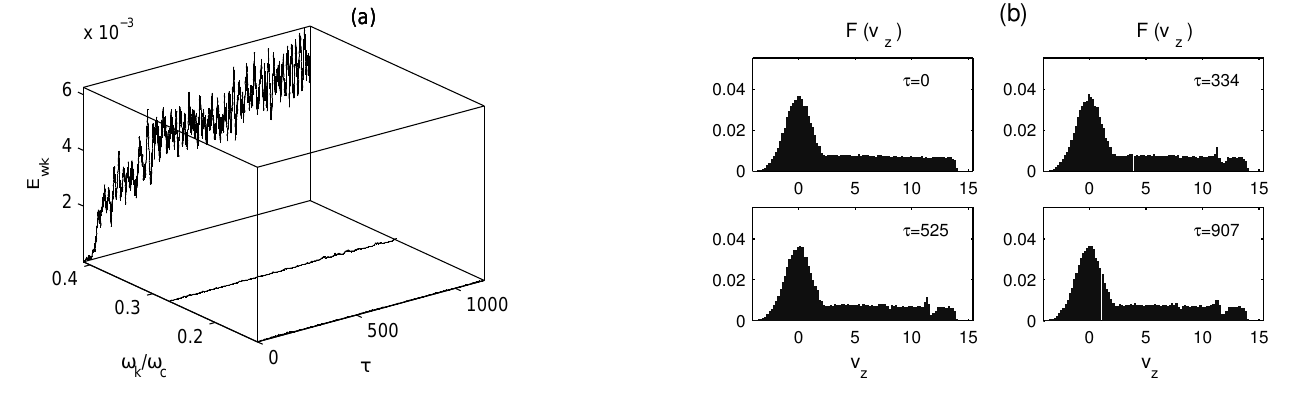
Fig. 1. Interaction of three waves with a particle distribution in the presence of a suprathermal tail of electrons extending in the parallel direction v z > 0. The waves’ frequencies and wave vectors are satisfying the matching conditions: k = k 1 + k 2 and ω k = ω k pling between the three waves is neglected. (a) Variation as a function of the normalized time τ = ω c t/ 2 π of the normalized wave energy (cid:12) (cid:12) (cid:12) (cid:12) ϕ 2 density E wk (proportional to (cid:12) (cid:12) ) of each of the three waves (each wave is indicated by its normalized frequency k , k 1 (cid:1) and (cid:0) ω k , k 2 (cid:1) , are negligibly small compared to that of the first one; (b) Parallel velocity distri- of the second and third waves, (cid:0) ω k 1 2 bution function F(v z ) at different times: τ = 0 , 334 , 525 , 907 . The electron distribution is modeled by a maxwellian in the perpendicular direction and by a thermal bulk and a suprathermal tail in the parallel direction (see (b) for τ = 0). The main normalized parameters are the following: p = 0 . 113 , k = ( k x ,k y ,k z ) = ( 0 . 2 , 0 . 15 , 0 . 12 ) , k 1 = ( − 0 . 2 , − 0 . 2 , − 0 . 04 ), k 2 = ( 0 . 4 , 0 . 35 , 0 . 16 ) , ω k /ω c = 0 . 411 , ω k ω k /ω c = 0 . 273 , 1ω/ω c ’ 0 . 005 (frequency mismatch), v R (m = 0 ) = 3 . 42 , v R 1 (m = 0 ) =− 3 . 32 , v R 2 (m = 0 ) = 1 . 7 (Landau m = 0 normalized 2 resonant velocities for each of the three waves), v R (m =− 1 ) = 11 . 7 ,v R 1 (m =− 1 ) =− 28 . 3 , v R 2 (m =− 1 ) = 7 . 9 (anomalous cyclotron m =− 1 resonant velocities) , v R (m = 1 ) =− 4 . 9 , v R 1 (m = ( 1 ) = 21 . 7 , v R 2 (m = 1 ) =− 4 . 5 (normal cyclotron m = 1 resonant velocities) , N =